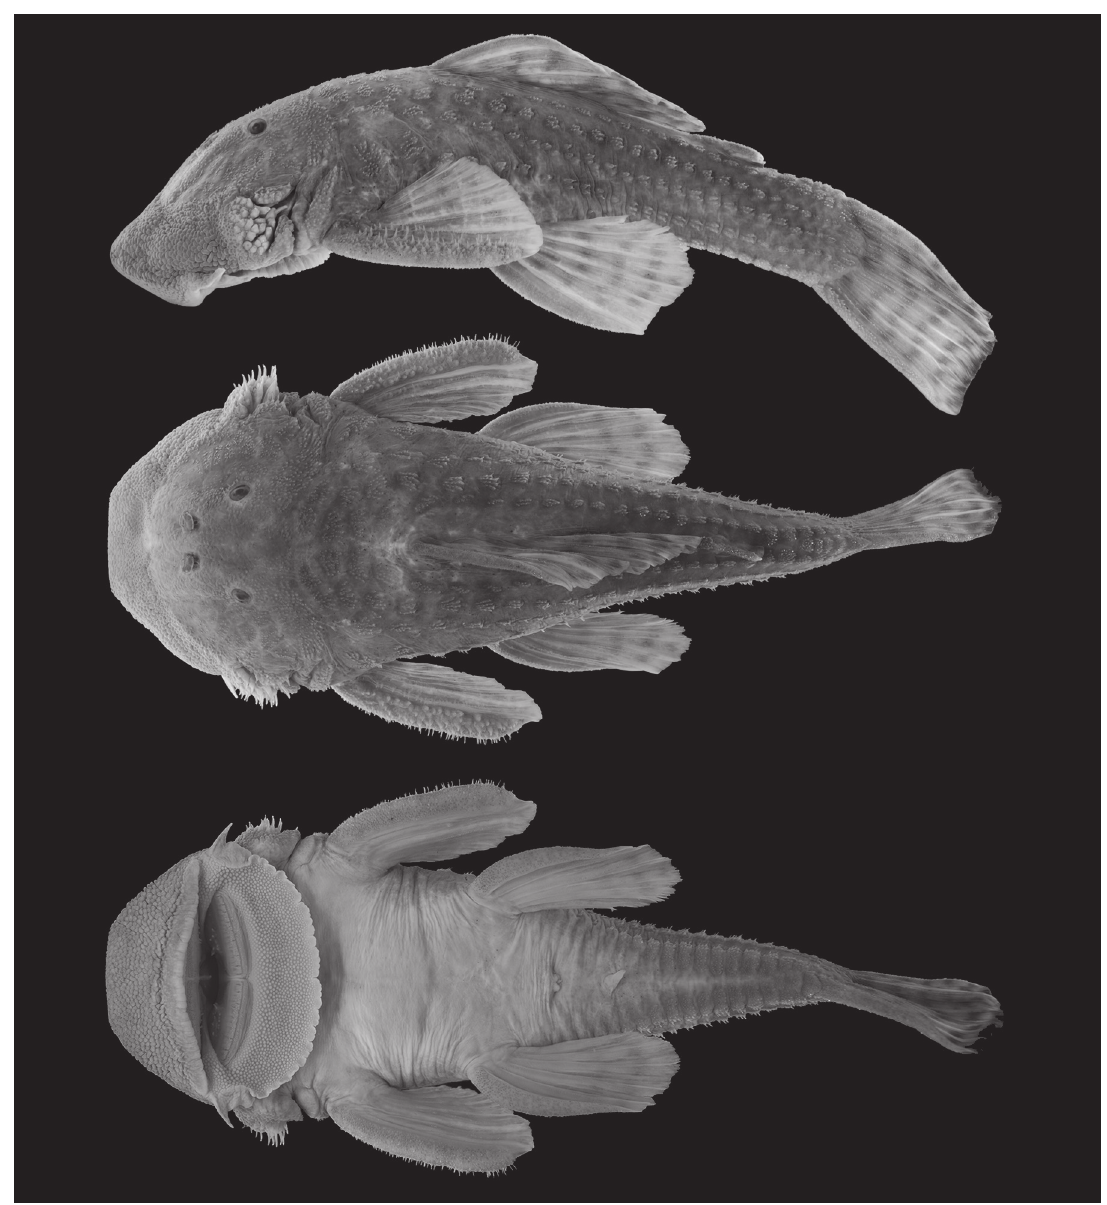
Fig. 1. Chaetostoma spondylus , new species, MUSM 33341, holotype, 119.7 mm SL, Peru, Departamento de